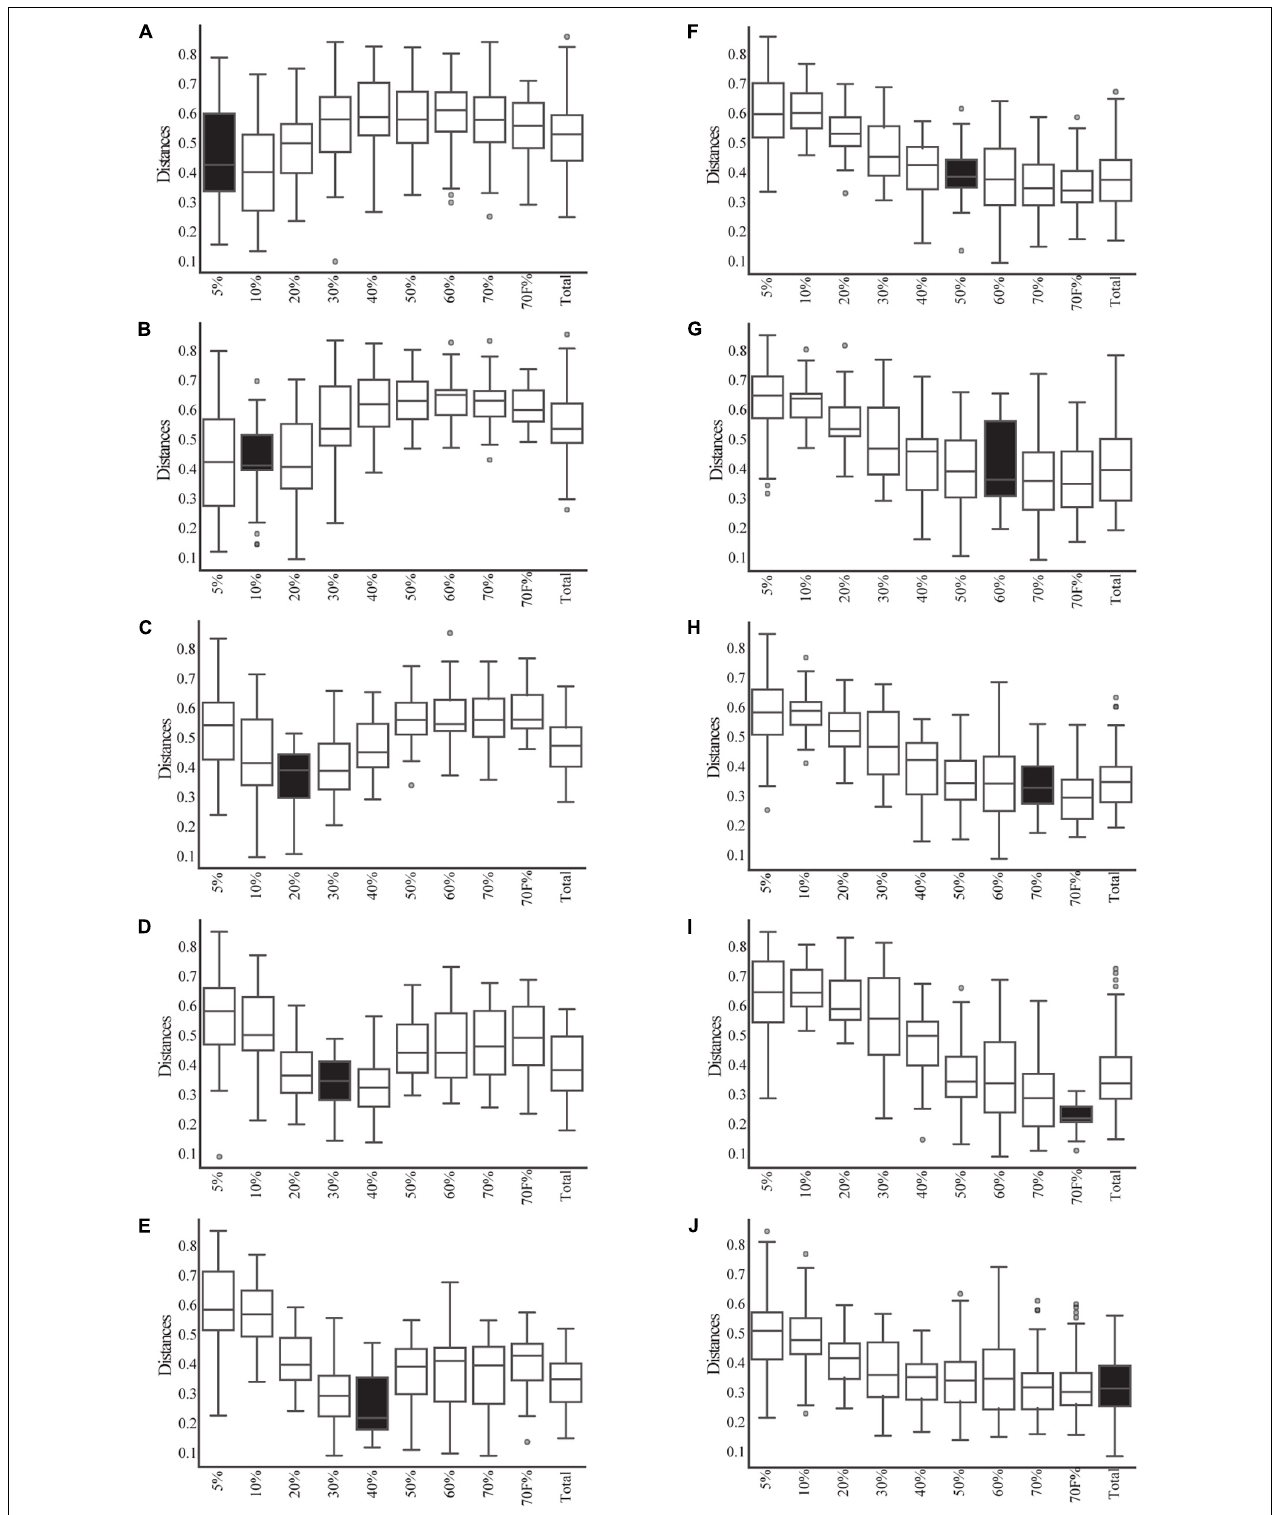
FIGURE 3 | Beta-diversity analysis based on weighted UniFrac between and within the fractions of the gradient and total samples. The distribution of the distances between each sample from each fraction of the gradient (and the total) and the samples from each other fraction of the gradient are shown in open box plots. The distances of samples within a given fraction of the gradient are shown in black box plots. (A–I) Correspond to each fraction of the gradient. (J) Corresponds to the distance of the total samples compared to all gradients and itself.